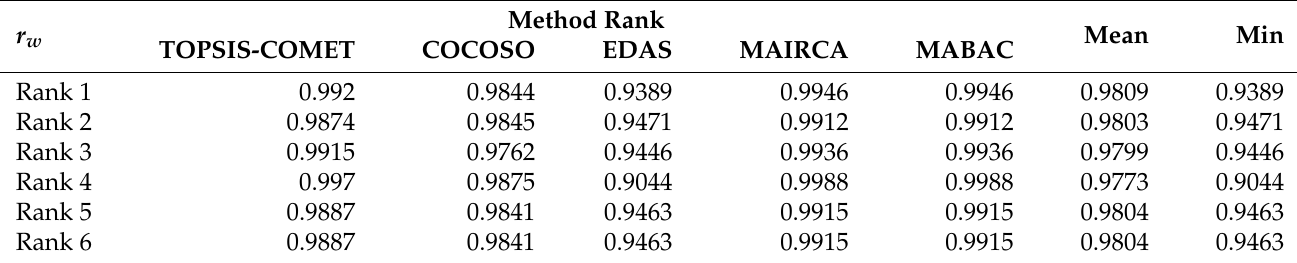
Table 17. Values of similarity coefficient r w for candidate compromise rankings with consideration of the whole